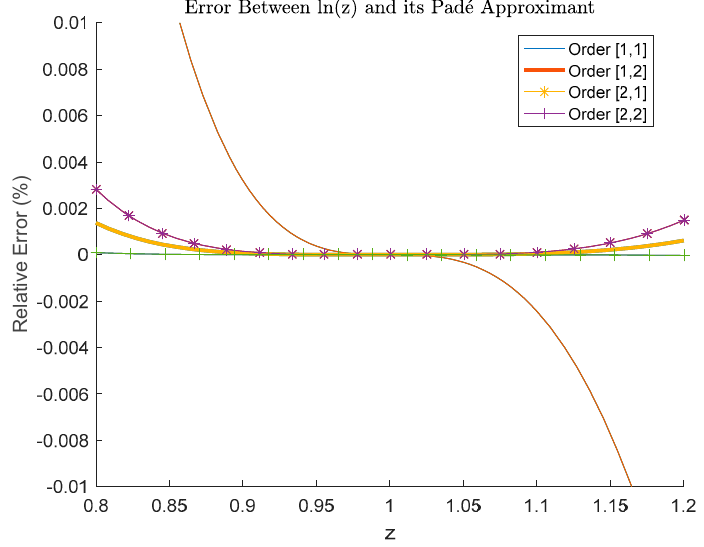
Figure 1. Relative error between ln ( z ) and its Padé approximants accurate for z ≈ 1. Table 1. Relative error in % of Padé approximant (2,3) for z in interval [0.6; 1,6].